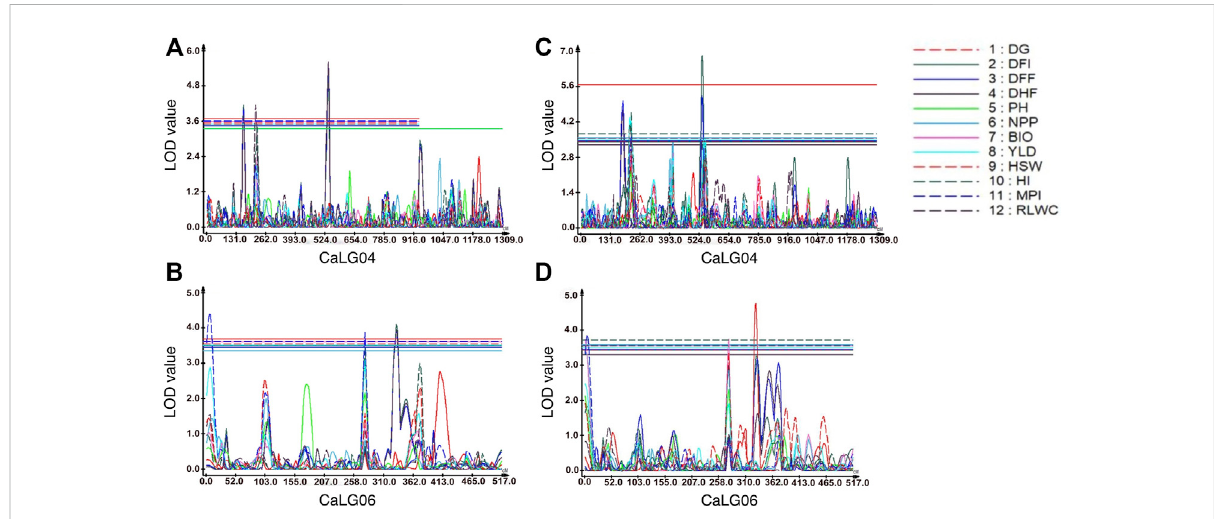
FIGURE 1 Genomic regions with QTLs for morphological and physiological traits. For traits evaluated at Faridkot, (A) QTLs for days to fl owering initiation (DFI),daysto50% fl owering(DFF),daysto100% fl owering(DHF),harvestindex(HI),andrelativeleafwatercontent(RLWC)weremappedonCaLG04; while (B) QTLs for days to fl owering initiation (DFI), days to 50% fl owering (DFF), days to 100% fl owering (DHF), yield (YLD), harvest index (HI), and membrane permeability index (MPI) were mapped on CaLG06. For traits evaluated at Ludhiana, (C) QTLs for days to fl owering initiation (DFI),